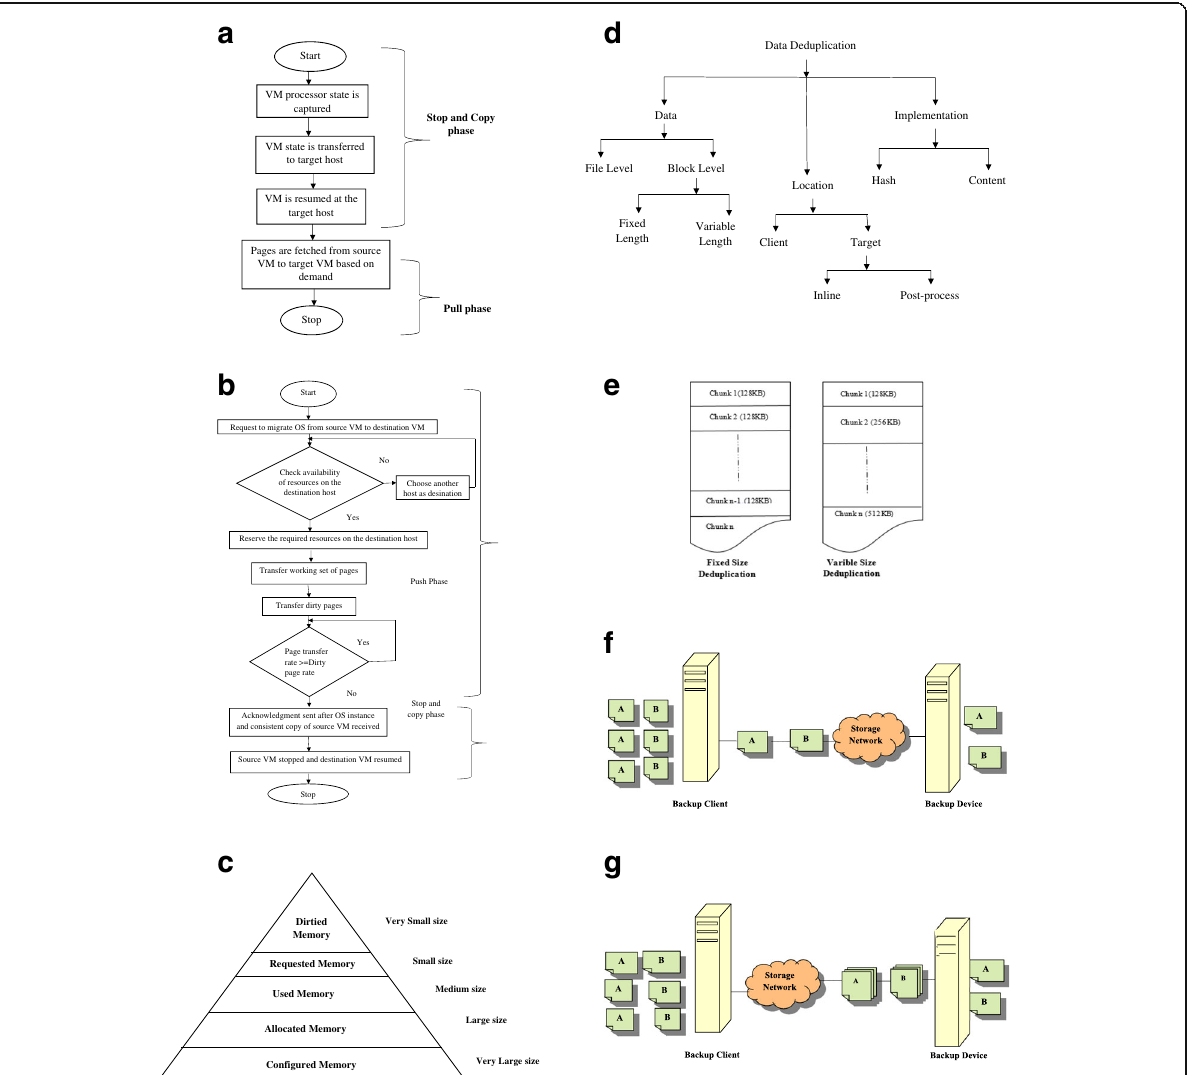
Fig. 2 a Post-copy approach with stop, copy and pull phases. b Pre-copy approach with iterative push, stop and copy phases. c VM Memory content categories. d Classification of Data deduplication techniques. e Block-Level Deduplication. f Client based Deduplication. g Target based